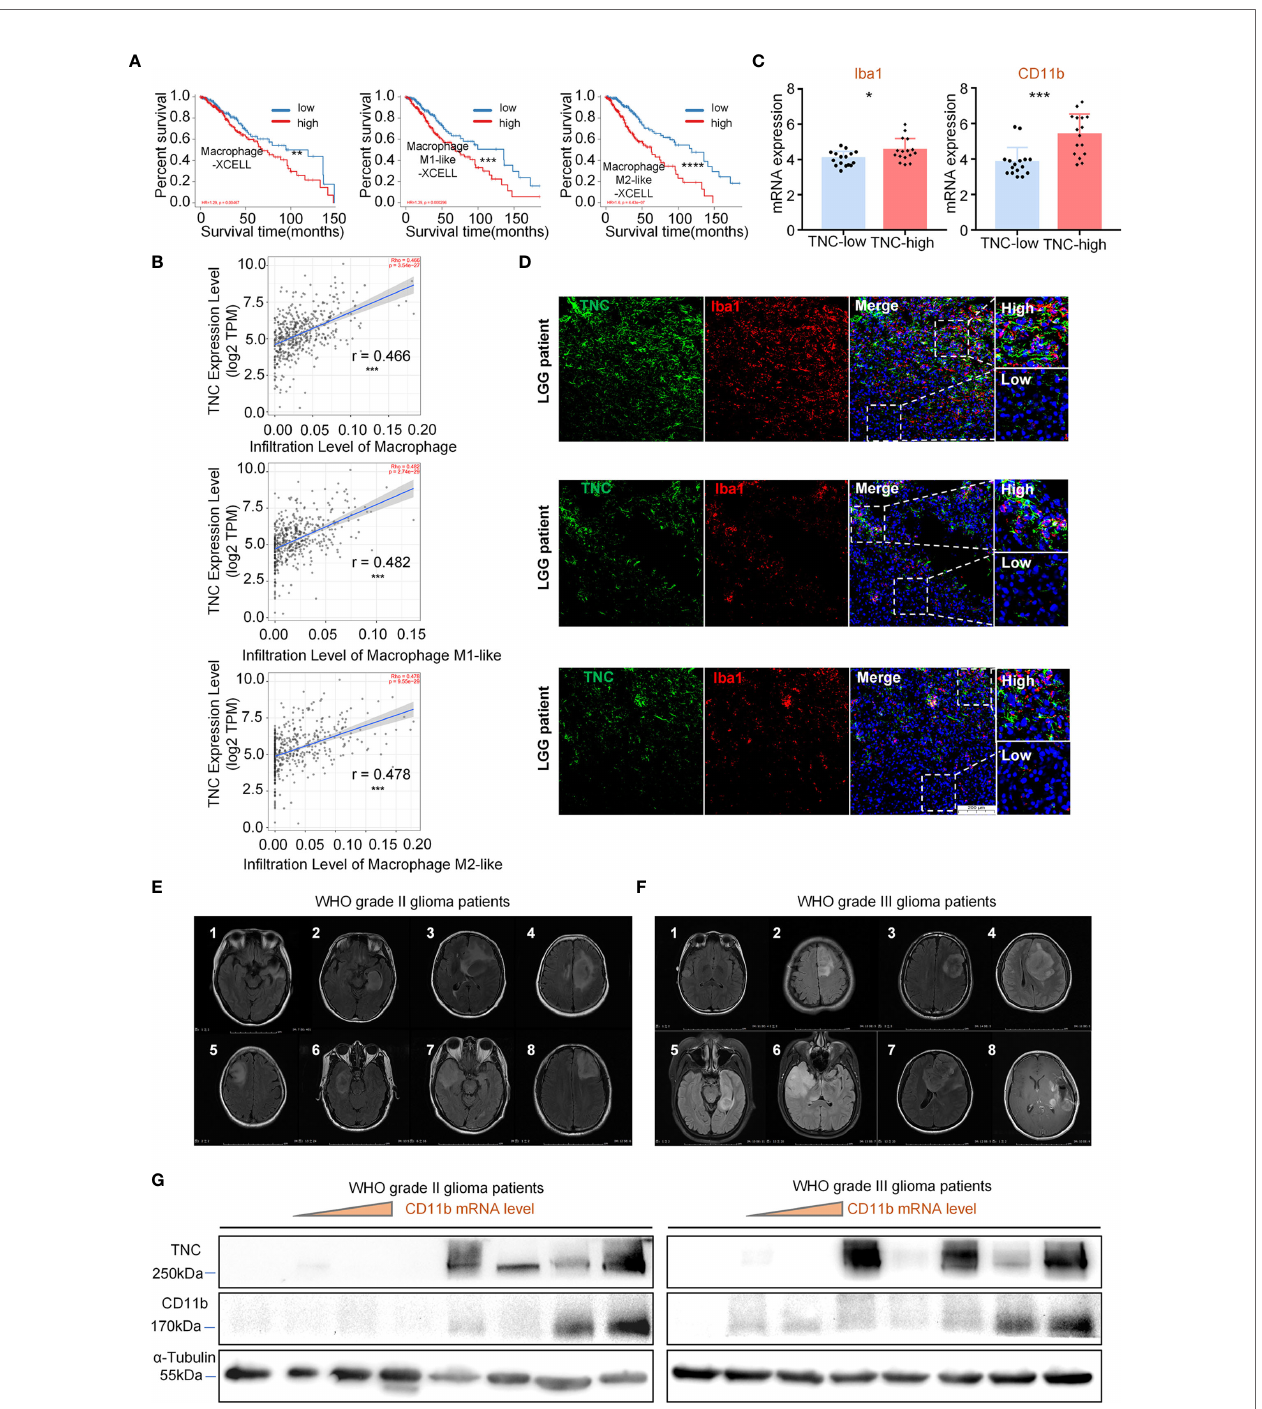
FIGURE 3 | TNC was related to GAM cell in fi ltration in LGGs (A) Kaplan-Meier survival analysis showing that the in fi ltration level of macrophages, M1-like cells, and M2-like cells with the prognosis of LGG patients in the TIMER database using the XCELL method. (** p < 0.01; *** p < 0.001; **** p < 0.0001) (B) The scatter plot indicating the correlation between TNC expression level (log 2 TPM) and the in fi ltration level of macrophages, M1-like cells, and M2-like cells in LGG patients using the TIMER database. (*** p <0.001) (C) qRT-PCR analysis of Iba1 and CD11b mRNA expression in 32 patients grouped by TNC mRNA level. (* p < 0.05; *** p < 0.001) (D) IF staining of TNC (green) and Iba1 (red) in human LGG samples. Representative images are shown. (Scale bars = 200 um ) (s) MRI images of patients with grade II (E) and grade III (F) gliomas.( n =16) (G) Immunoblotting of TNC and CD11b in grade II and III glioma patients sorted by CD11b mRNA level. (The samples correspond to the patients in (E, F)